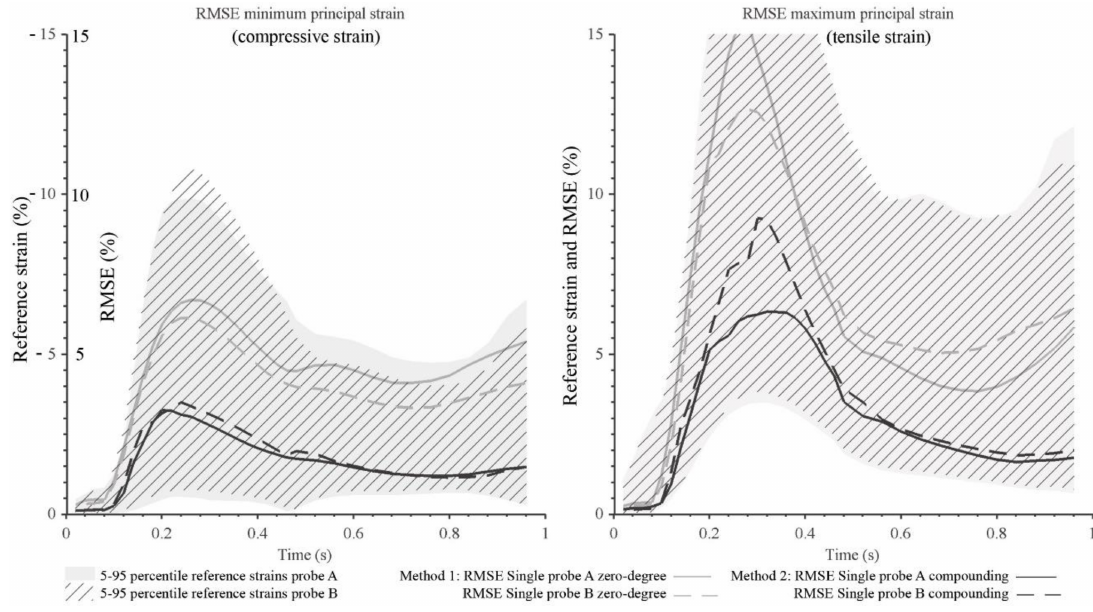
Figure 11. The RMSE of the compressive and tensile strain components for the complete cardiac cycle for the zero-degree and compounding method for both probes. Please note the double axis for the RMSE minimal principal strain, in which the RMSE is always positive; the 5th–95th percentiles strain range is